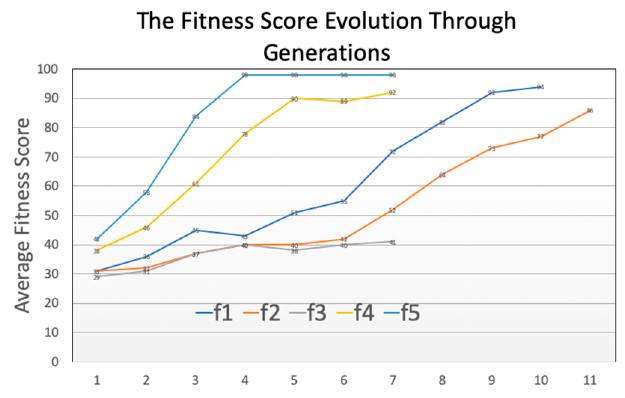
Figure 14. The fitness score evolution of the whole population through generations.